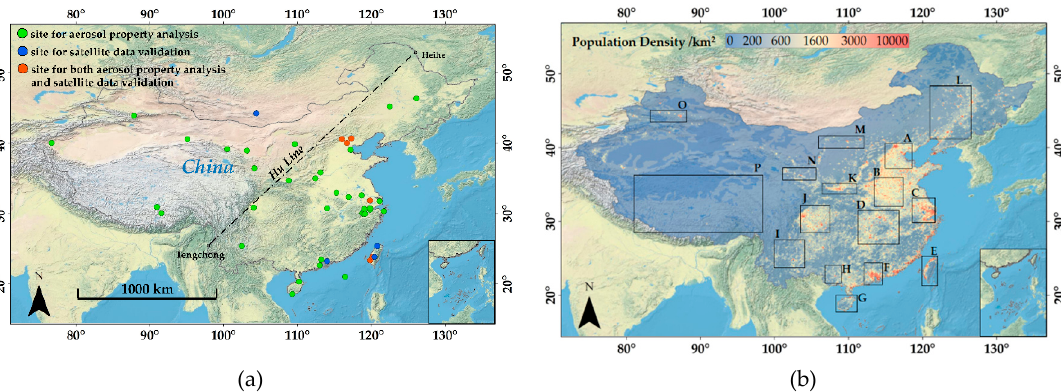
Figure 1. Map of ( a ) study domain and the distribution of the AERONET sites involved in this study and ( b ) population density and the geographical locations of 16 selected regions. In Figure 1a, green, blue, and orange dots represent the ground-based sites used for aerosol property analysis, satellite data validation, and both aerosol property analysis and satellite data validation, respectively. The black dotted line is the Hu Line (also known as Heihe-Tengchong Line).